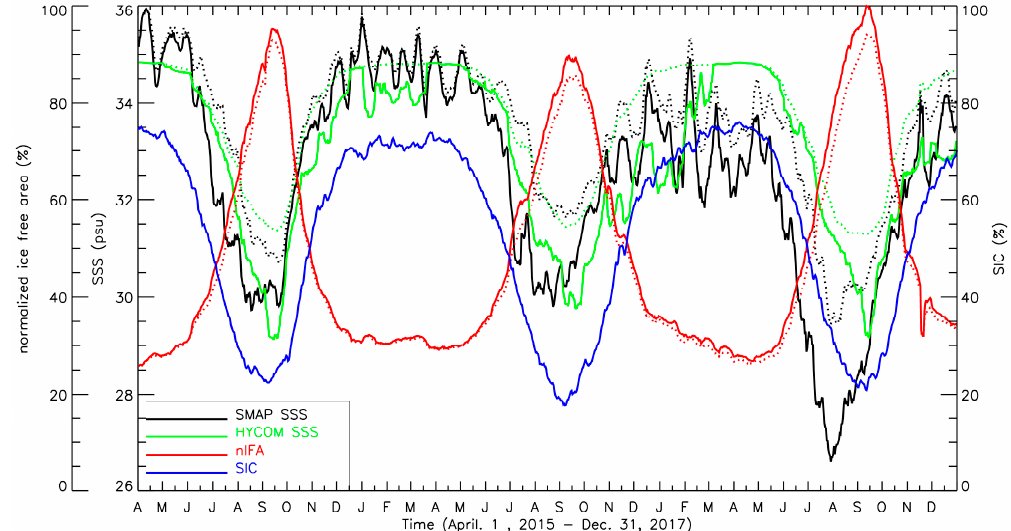
Figure 5. The time series of SMAP SSS (black) and HYCOM SSS (green) averaged in the domain North of 65 ◦ N in the ice-free-area (red) over all retrievals (solid line), or with outliers removed (dotted line). Outliers are identified as where the absolute differences from the daily mean exceeding three times of the standard deviation (~1 to 5%). Ice-free-area is normalized (nIFA) by the record maximum (observed in September 2017). Sea ice concentration (SIC) (blue) is averaged daily North of 65 ◦ N including zero and non-zero values.